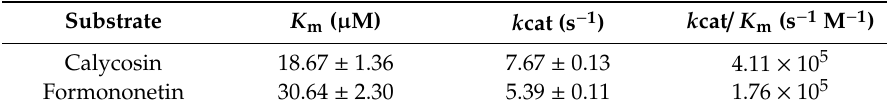
Table 1. Kinetic parameters of UGT88E18 toward calycosin and